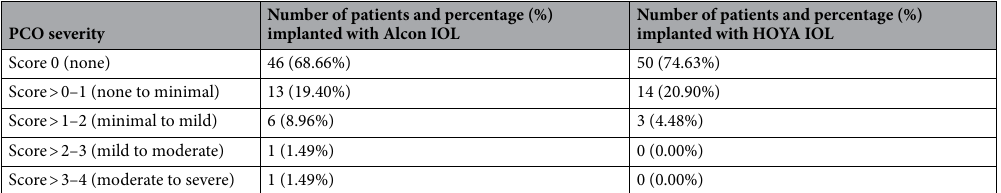
Table 3. Frequency and proportion of subjective posterior capsule opacification (PCO) at 3-years. IOL intraocular lens.